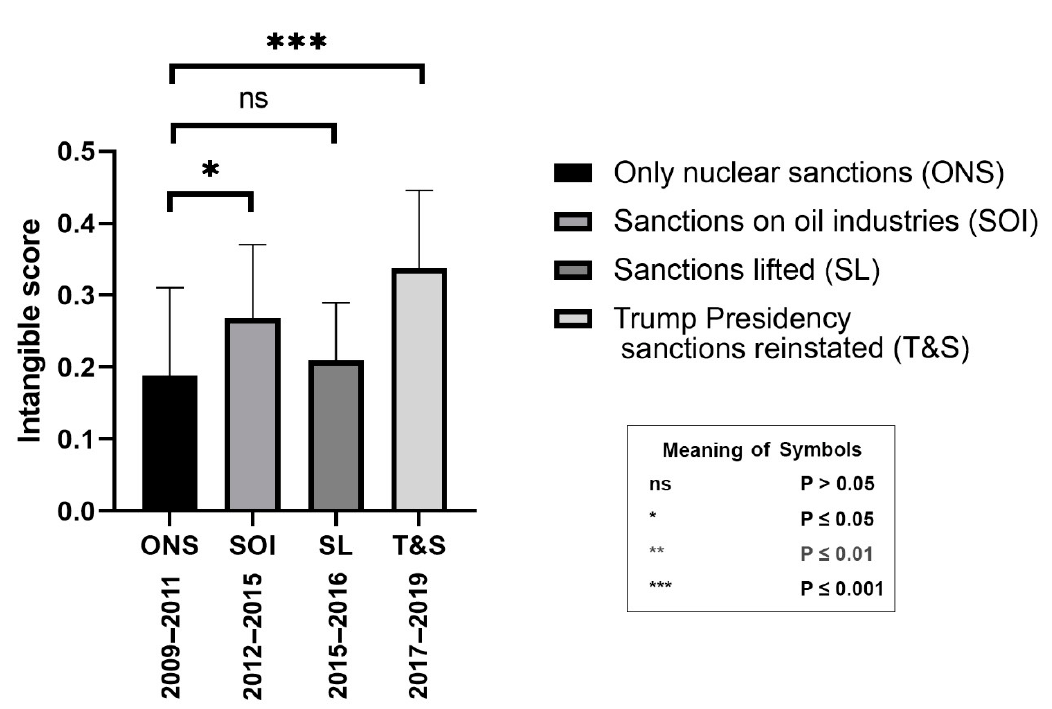
Figure 8. The relationship between the sanctions and intangible score in Dubai, 2009–2019.